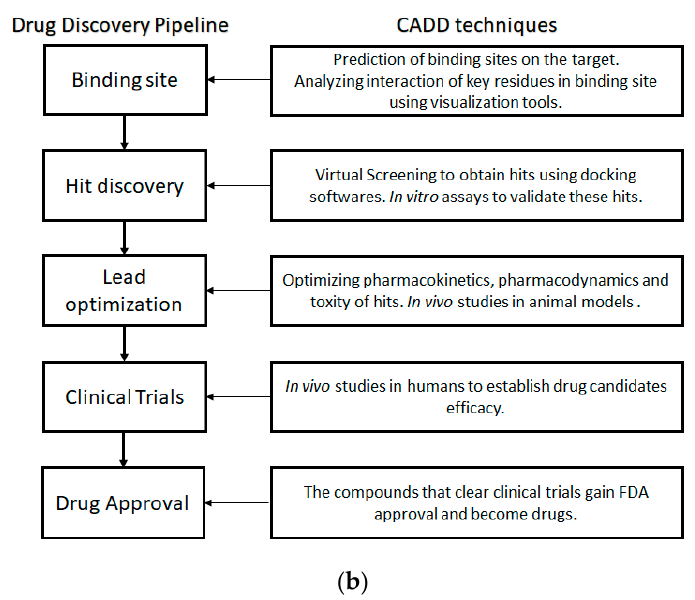
Figure 1. ( a ) Evolution of BCa treatment and therapy; and ( b ) Computer-aided drug design techniques for standard drug discovery pipeline.